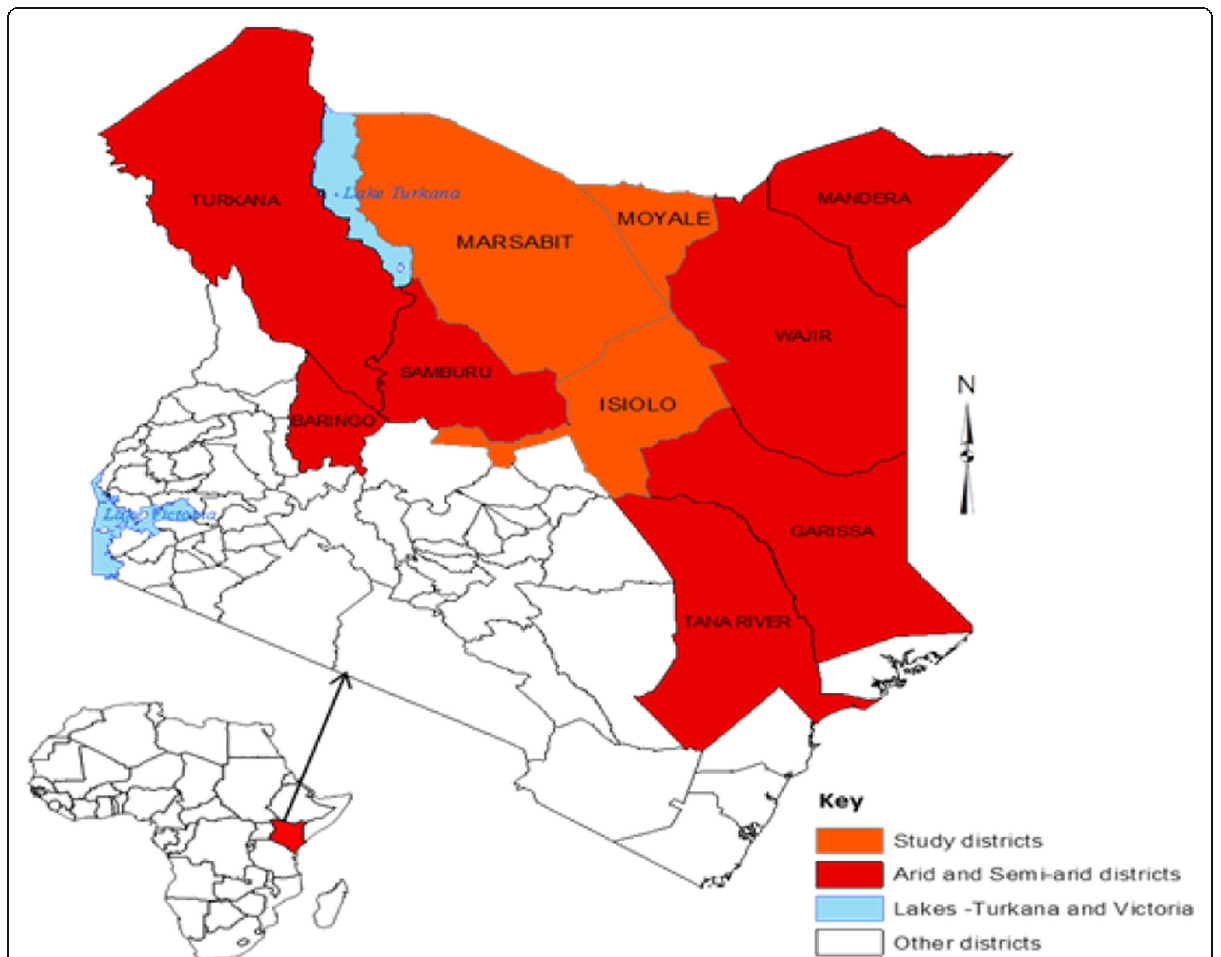
Figure 1 Map of Kenya showing study districts: Marsabit, Moyale and Isiolo. Source: drawn by the author with the help of the Department of Geography and Environmental Resources at Southern Illinois